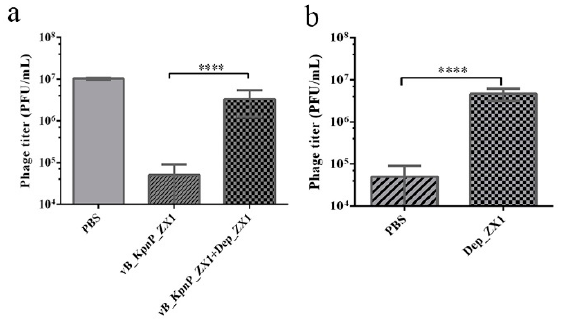
Figure 6. Depolymerase Dep_ZX1 reduces the adsorption of phage vB_KpnP_ZX1 to K. pneumoni ‐ ae 111 ‐ 2. ( a ) Phage titer in supernatant of competitive adsorption test between vB_KpnP_ZX1 and Dep_ZX1. ( b ). Phage titer in the supernatant of phage adsorption test after K. pneumoniae 111 ‐ 2 treated with Dep_ZX1. p < 0.05 (*), 0.01 < p < 0.05 (**), 0.001 < p < 0.01 (***) and p < 0.001 (****).